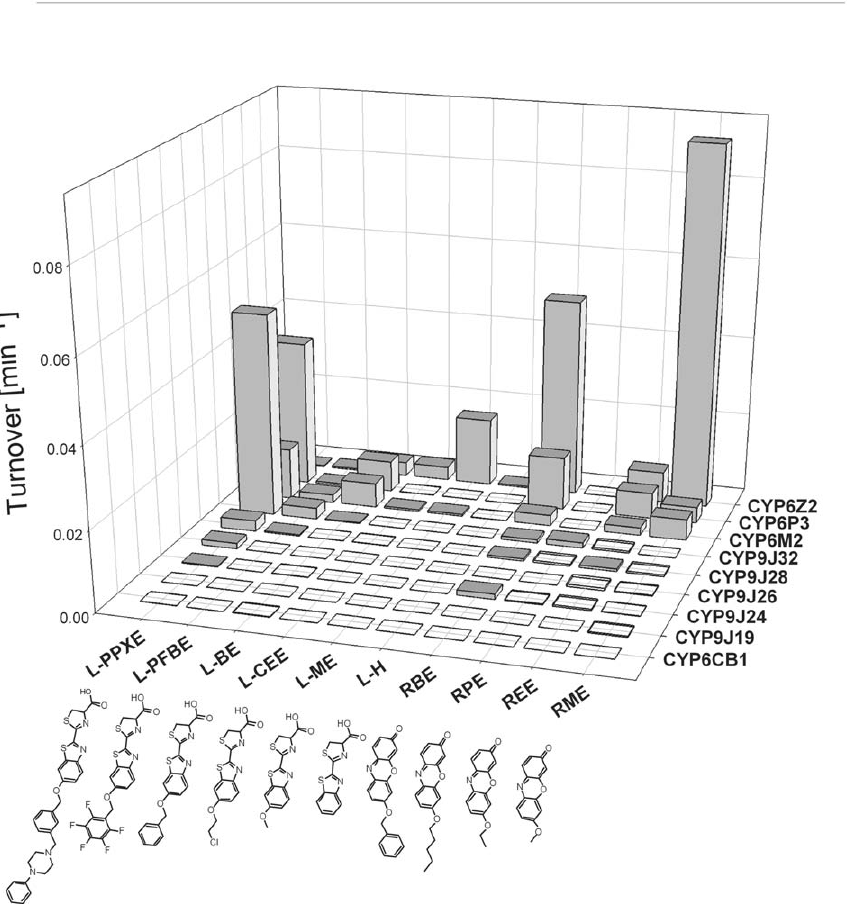
Figure 3. Metabolism of probe substrates by Ae.aegypti and An.gambiae P450s. Solid bars indicate significant turnover of probe substrates compared to the negative ( 2 NADPH) control reactions (N=3, T-test). The chemical structures of the resorufin and lucerifin-based probe substrates are shown below the X-axis.